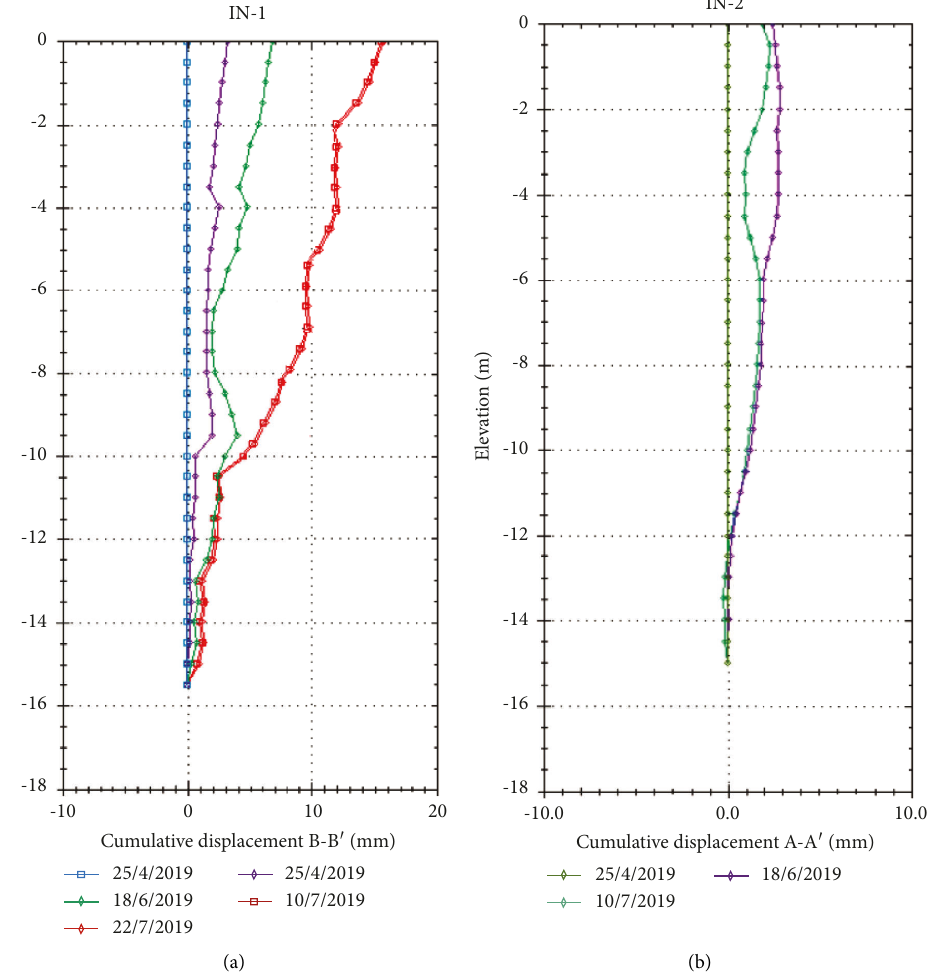
Figure 9: Inclinometer reading plot for (a) PTP and (b) RCP.